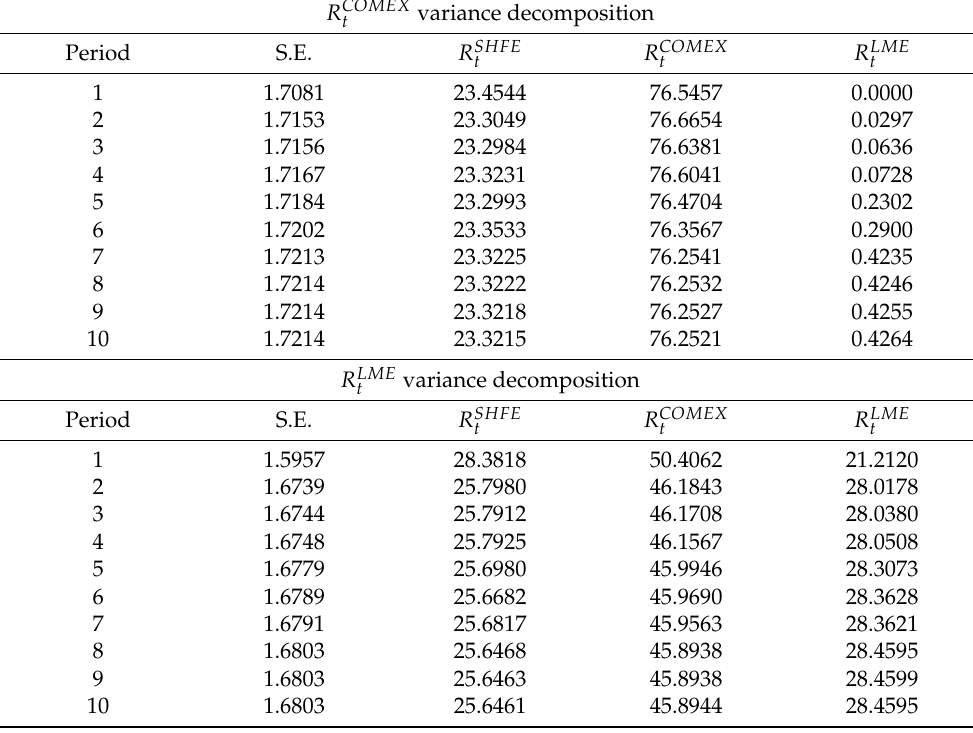
Figure 8. Impulse response of Shanghai copper to London copper return rate. Figure 8 indicates that the impact of London copper on the yield of Shanghai copper